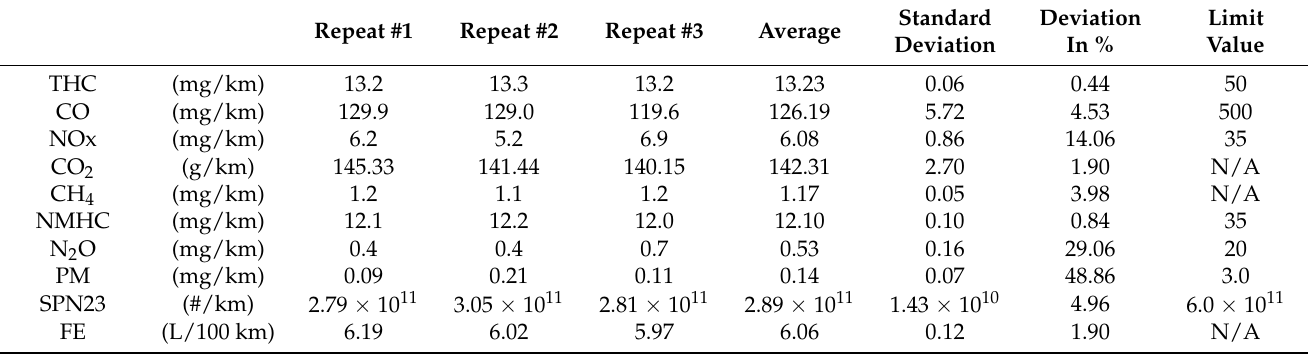
Table 2. Results of three repeated WLTC